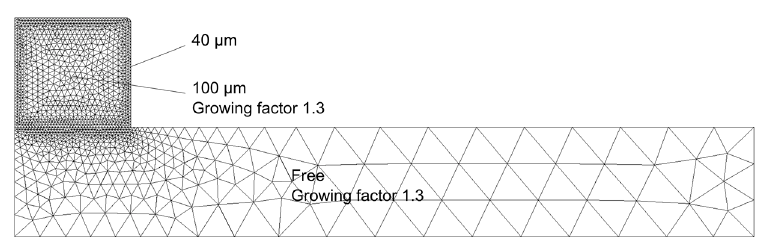
Figure 6. Mesh Figure 6. Mesh configuration.